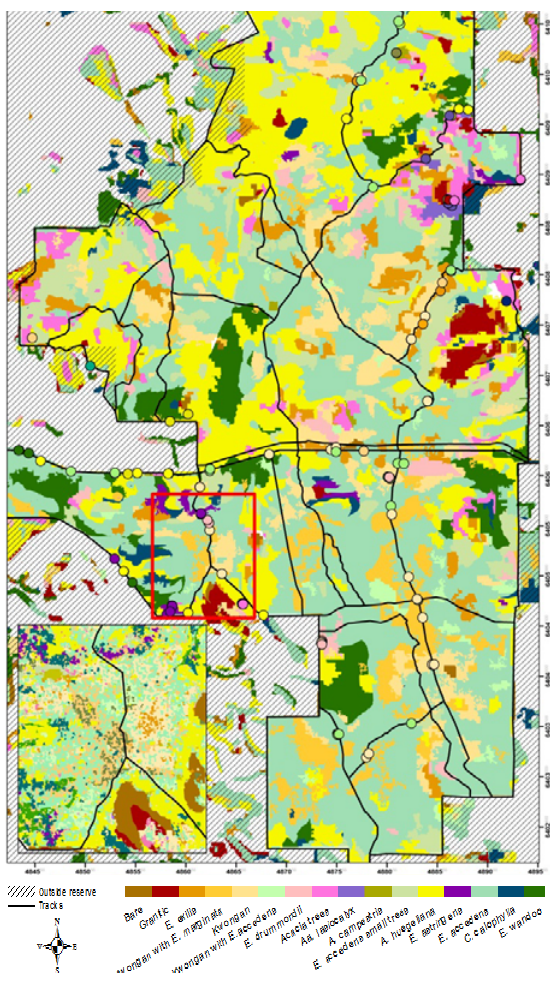
Figure 3. Classifications for vegetation objects in Boyagin Nature Reserve. The circles indicate the approximate location and vegetation type of observations in the field. The inset shows the detailed classification for objects at the tree